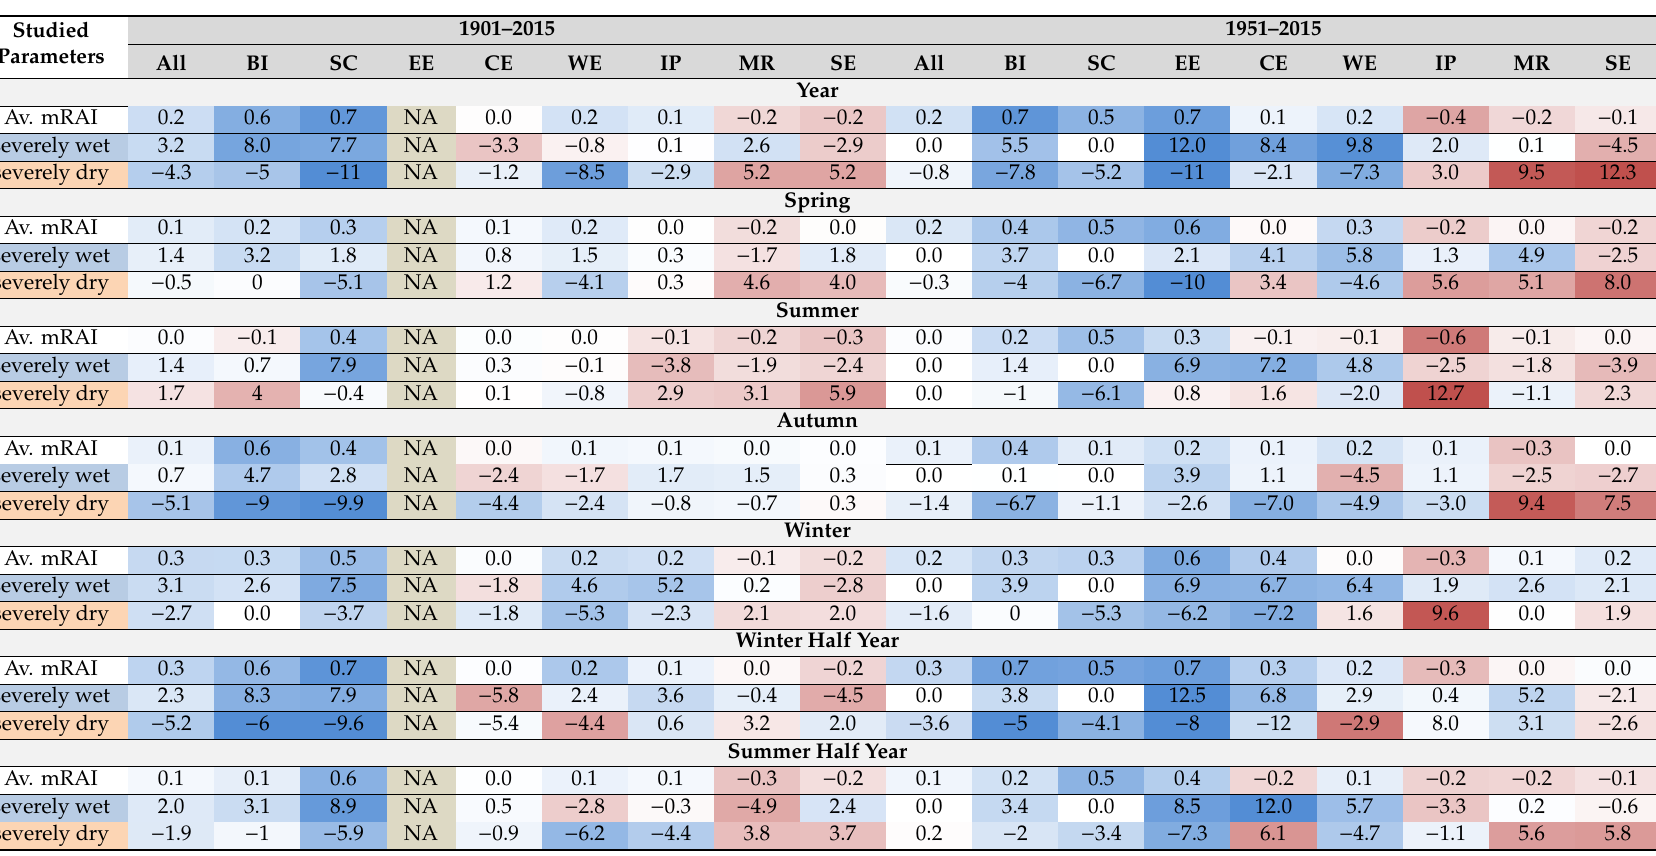
Table 5. Absolute linear trends for Europe and its eight sub-regions (for region abbreviations please refer to Figure 1) of the average precipitation conditions as well as severely wet and dry conditions for the year (mRAI-12 for December), the half years (mRAI-6 for March and September), and the seasons (mRAI-3 for May, August, November, and February). The trends of two periods (1901–2015 and 1951–2015) are shown. Blue background colors indicate trends towards wetter conditions, while red background colors illustrate trends towards drier conditions. The darker the color the larger the trend. NA indicates that no trend has been computed due to the restricted data